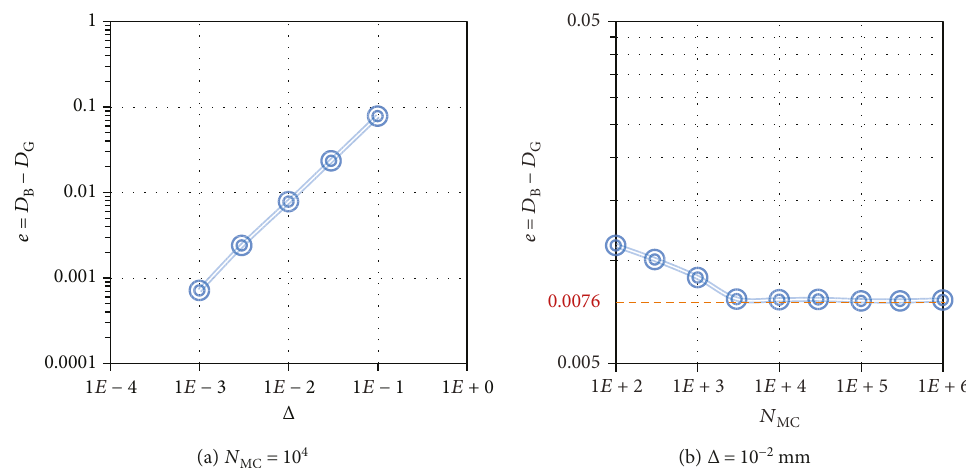
Figure 5: Sensitivity tests of the MPD estimates to discretization the length Δ and ensemble size N